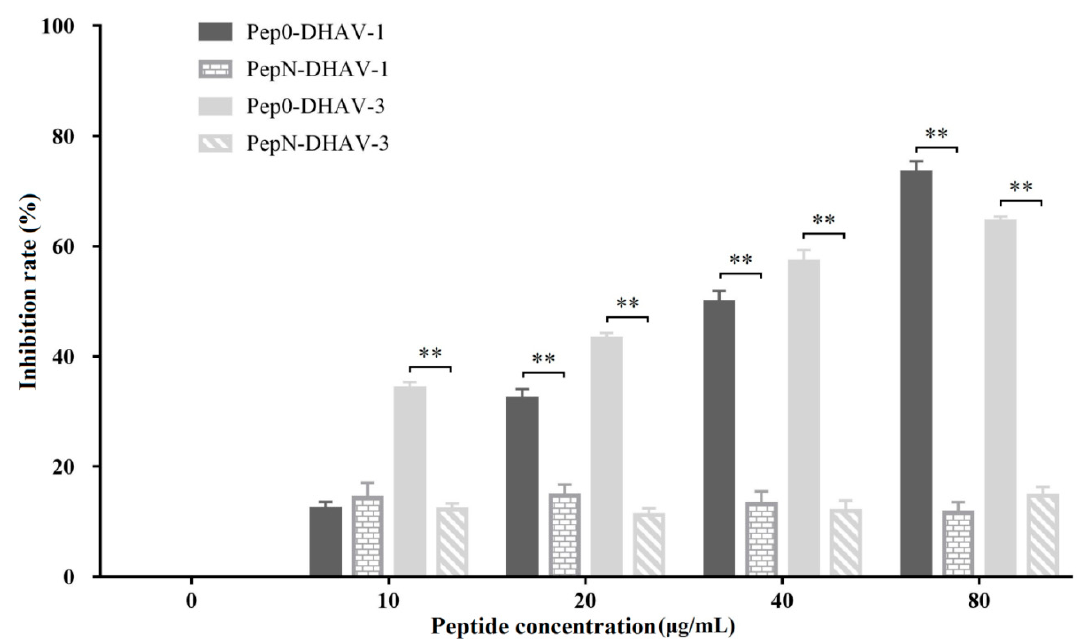
Figure 7. Influence of Pep0 with di ff erent concentration on inhibition of DHAV infections. Six-well plates were seeded with equivalent DEH cells and infected with Pep0-DHAV mixtures. The numbers of viral copies were measured using RT-qPCR. The inhibition rate was calculated using the formula (DHAV copies in DHAV singly infection group—DHAV copies in Pep0-DHAV infection group) / DHAV copies in DHAV singly infection group × 100%. Values represent three independent experiments with triplicates for each experiment. **, p < 0.01.